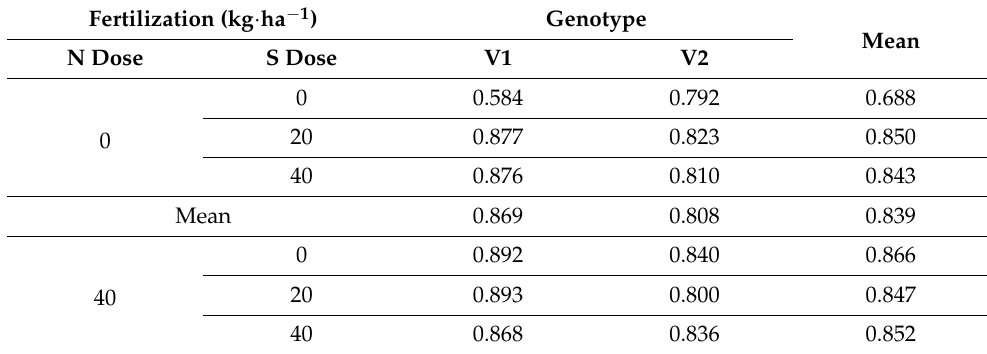
Figure 6. Agronomic efficiency of nitrogen doses. Table 4. NDVI of winter wheat genotypes under